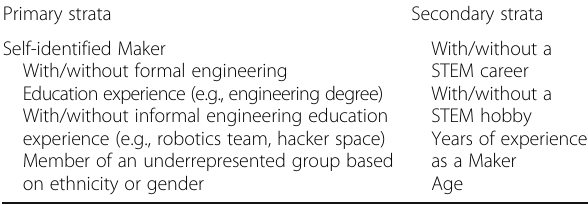
Table 3 Stratifications for purposeful